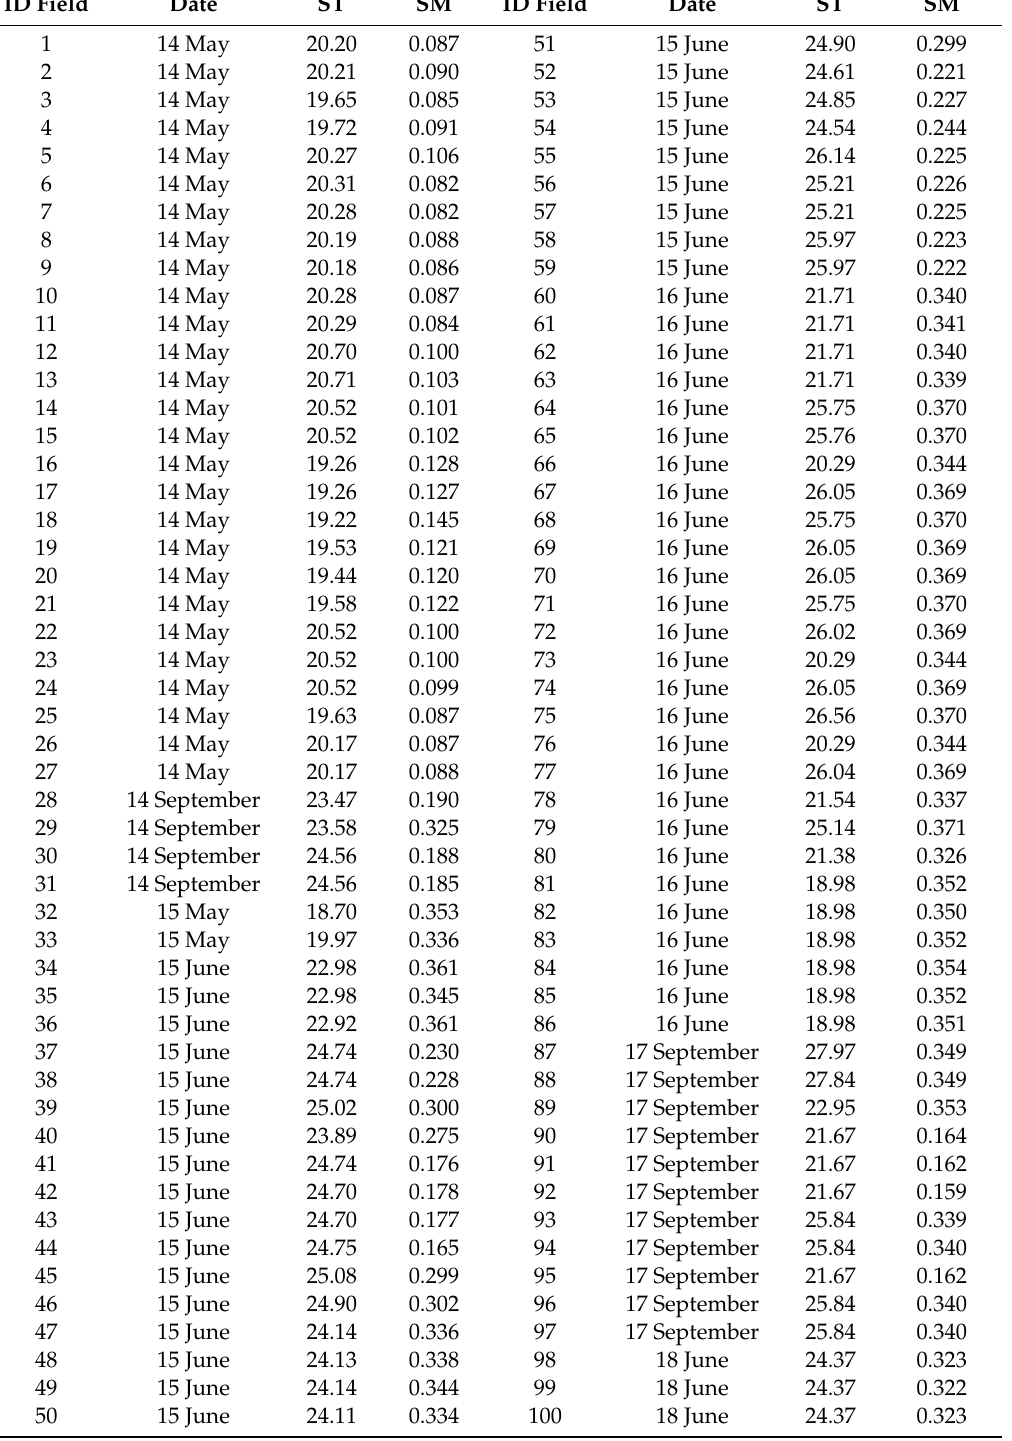
Table A1. Average values of soil temperature (ST ◦ C) and soil moisture (SM measured in the interval 0–1) of the 30-days reference period prior to the sampling date for each